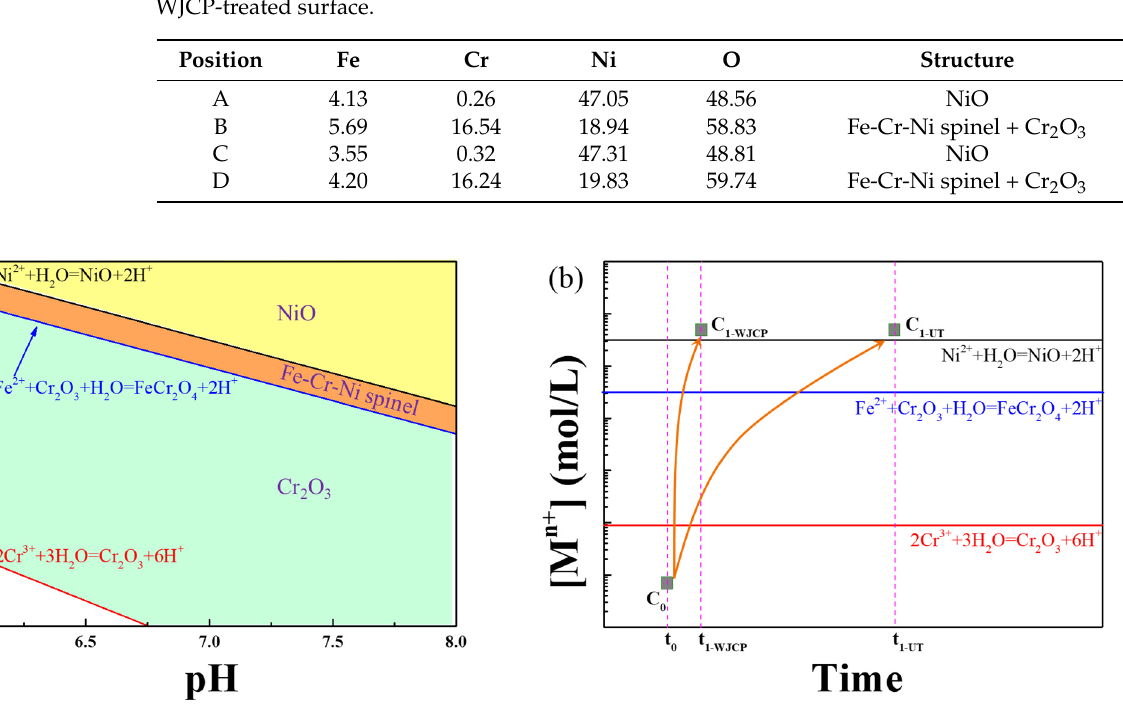
Figure 4. Thermodynamic–kinetics deposition sequence for the formation of oxide scales ( a ) and the schematic diagram of ion concentration change ( b ) in 600 MA. Table 3. Chemical composition (at. %) and structure of the oxide scale formed on the UT and WJCP- treated surface.